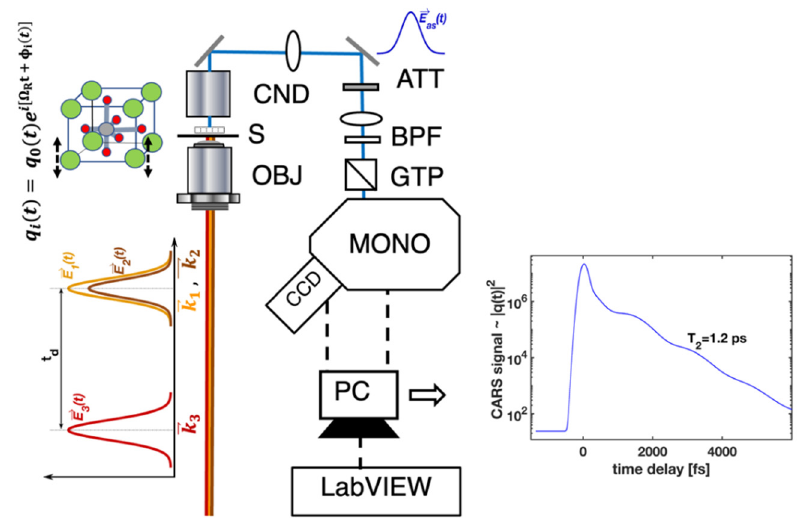
Figure 1. Schematic of the experimental setup. Pulsed fields E 1,2 ( t ) are used to coherently drive lattice vibrations at a specific frequency Ω R . The E 1 ( t ) field is provided by a pulsed